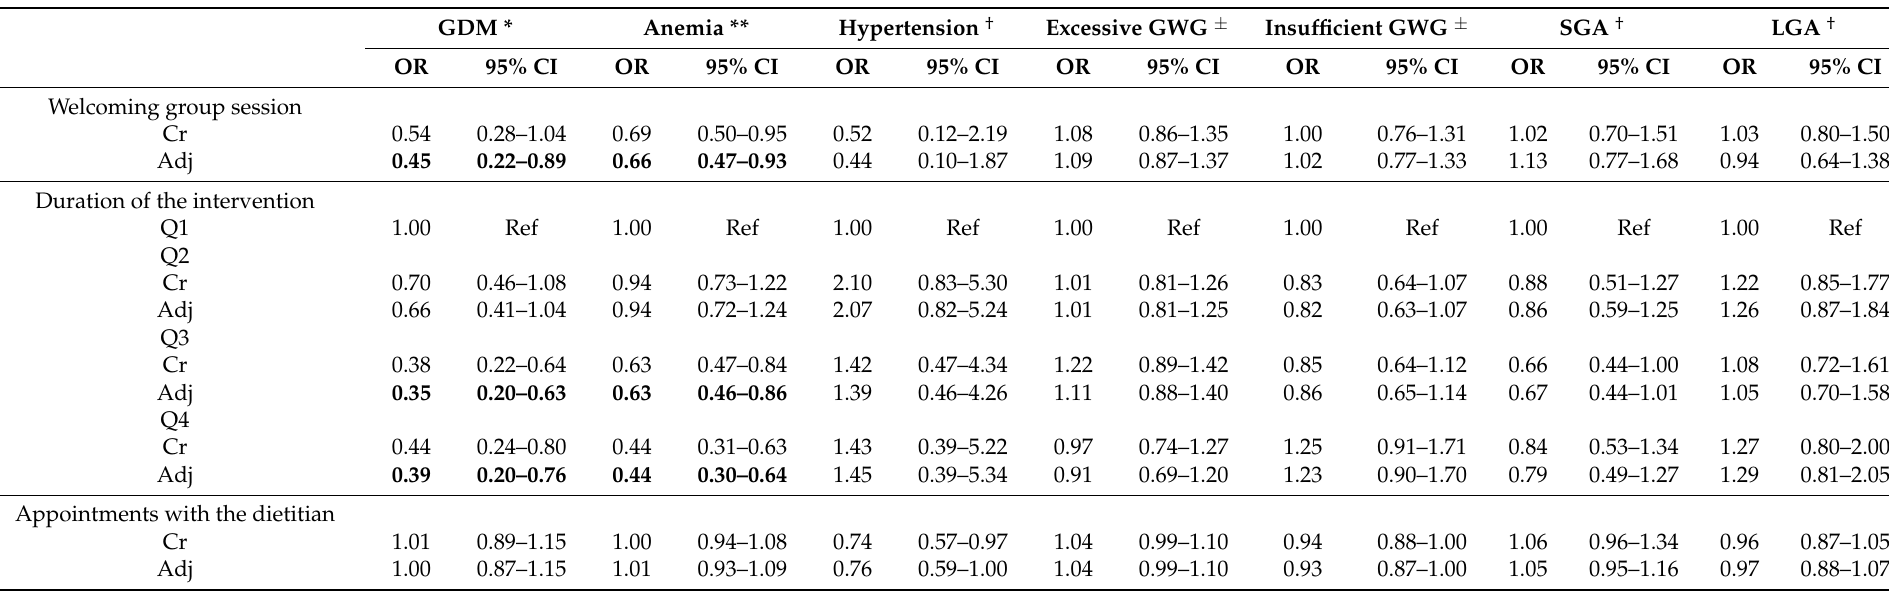
Table 2. Odds ratio of adverse pregnancy and birthweight outcomes according to structural features of the